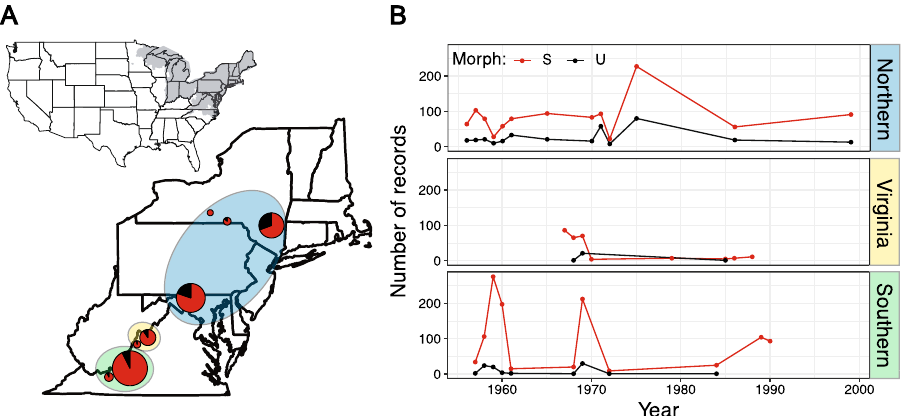
Figure 2. ( A ) The inset map shows (in gray) the range of Plethodon cinereus in the United States 96 . Specimen geolocations, separated by less than 15 km, were composited into eight sites. These sites are noted with color morph frequencies (black = unstriped, red = striped); the size of each pie reflects the number of composited P. cinereus records from each locality. The colored ellipses around pies indicate the mitochondrial clades to which the sampled localities belong, based on the analysis and mitochondrial clade names from Radomski et al. 50 : blue = Northern clade, yellow = Virginia clade, green = Southern clade. This map was created with R version 3.6.1 (https:// www.r- proje ct. org/). ( B ) The number of P. cinereus records by morph, collection year (indicated with a point), and mitochondrial clade examined in this study. Color morph and clade colors match